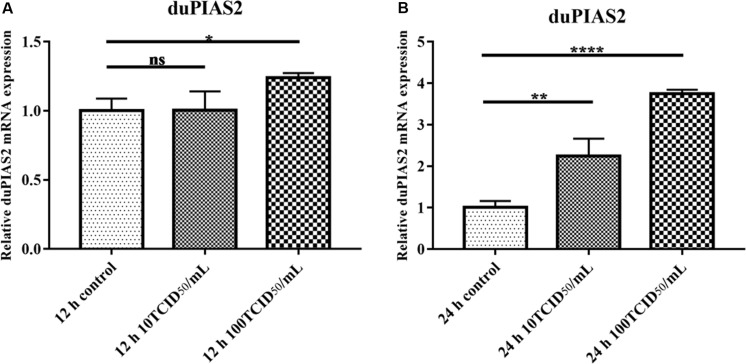
Relative expression of duPIAS2 in DEF cells infected with DK212. DEF cells were cultured in six-well plates until 90% confluence and infected with 10 and 100 TCID50/mL of DK212. At 12 h (A) and 24 h (B) post-infection, the expression of duPIAS2 mRNA was measured by qRT-PCR. duPIAS2 mRNA levels were expressed as relative mRNA indexes, calculated as index (duPIAS2 mRNA copy number/GAPDH mRNA copy number) of test group by index of control group. The experiment was repeated three times. The error bars represent the means and SDs (n = 3) and are compared using a student’s t-test. nsP > 0.05, *P < 0.05; **P < 0.01, ****P < 0.0001.